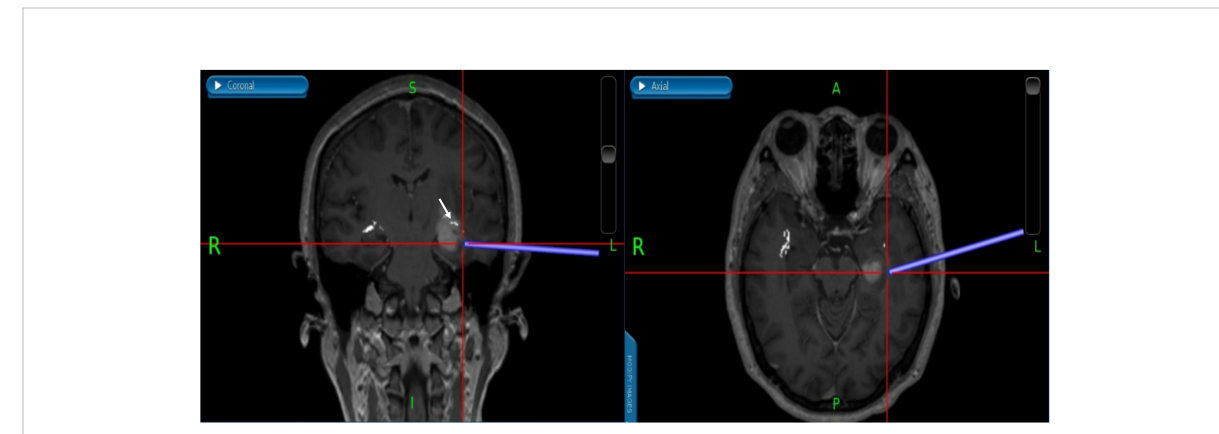
FIGURE 5 (Patient No.12) According to the relationship between tumor and OpR, the surgical approach is adjusted to the inferior temporal gyrus approach. We successfully reached the tumor under the guidance of neuronavigation and avoided OpR damage. The white part indicated by the white arrow is the OpR. OpR, optic